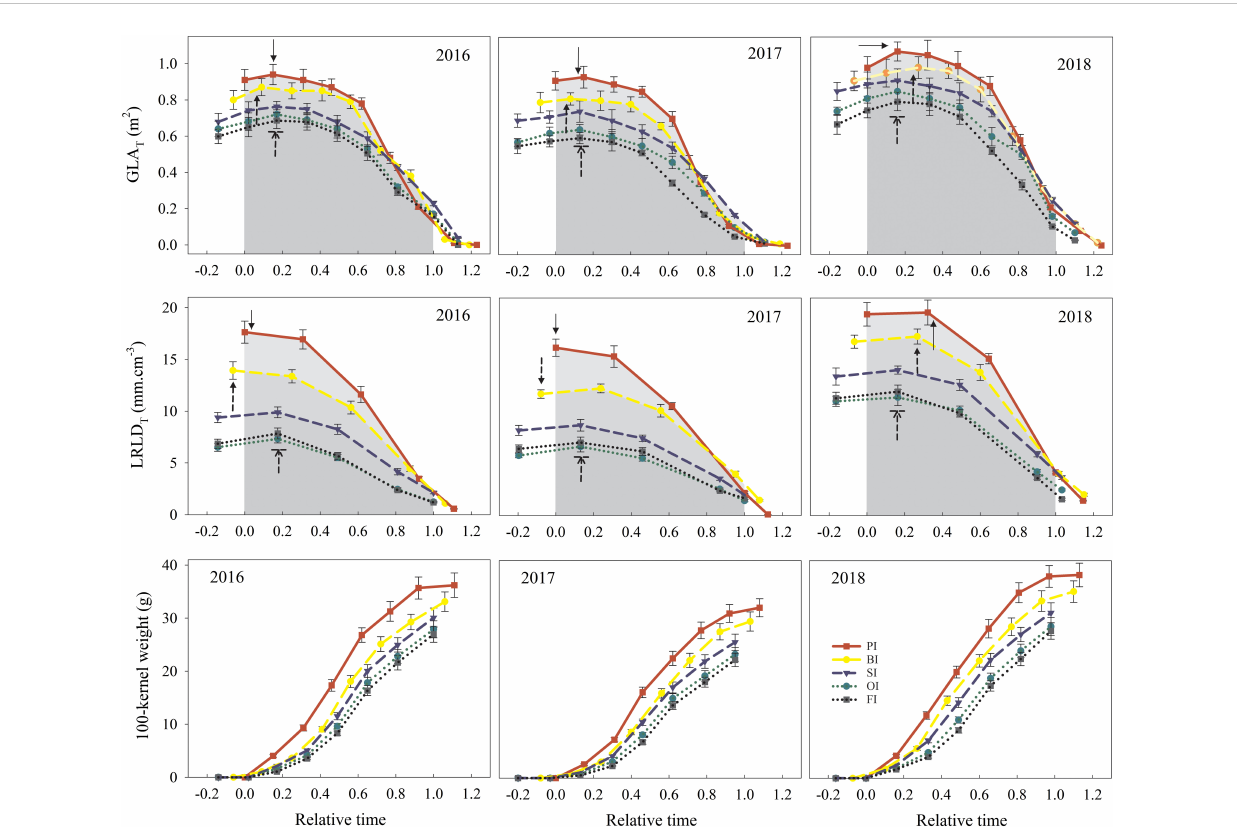
FIGURE 7 Total green leaf area per plant ( GLA T ), total live root length density per plant ( LRLD T ), and 100-kernel weight dynamics during the reproductive period. PI and BI represent drip irrigation under plastic fi lm mulch and biodegradable fi lm mulch, respectively; SI, drip irrigation incorporating straw returning; OI, drip irrigation with the tape buried to a shallow soil depth; FI, furrow irrigation. Relative time is the ratio of days after silking to the duration from silking to maturity. Gray area indicates the integral value of GLAT and LRLDT from silking (relative time = 0) to maturity (relative time = 1). Solid arrow for PI, dotted arrow for BI, and dotted arrow for SI; OI and FI with a line indicate the GLAmax or LRLDmax. The error bars represent standard